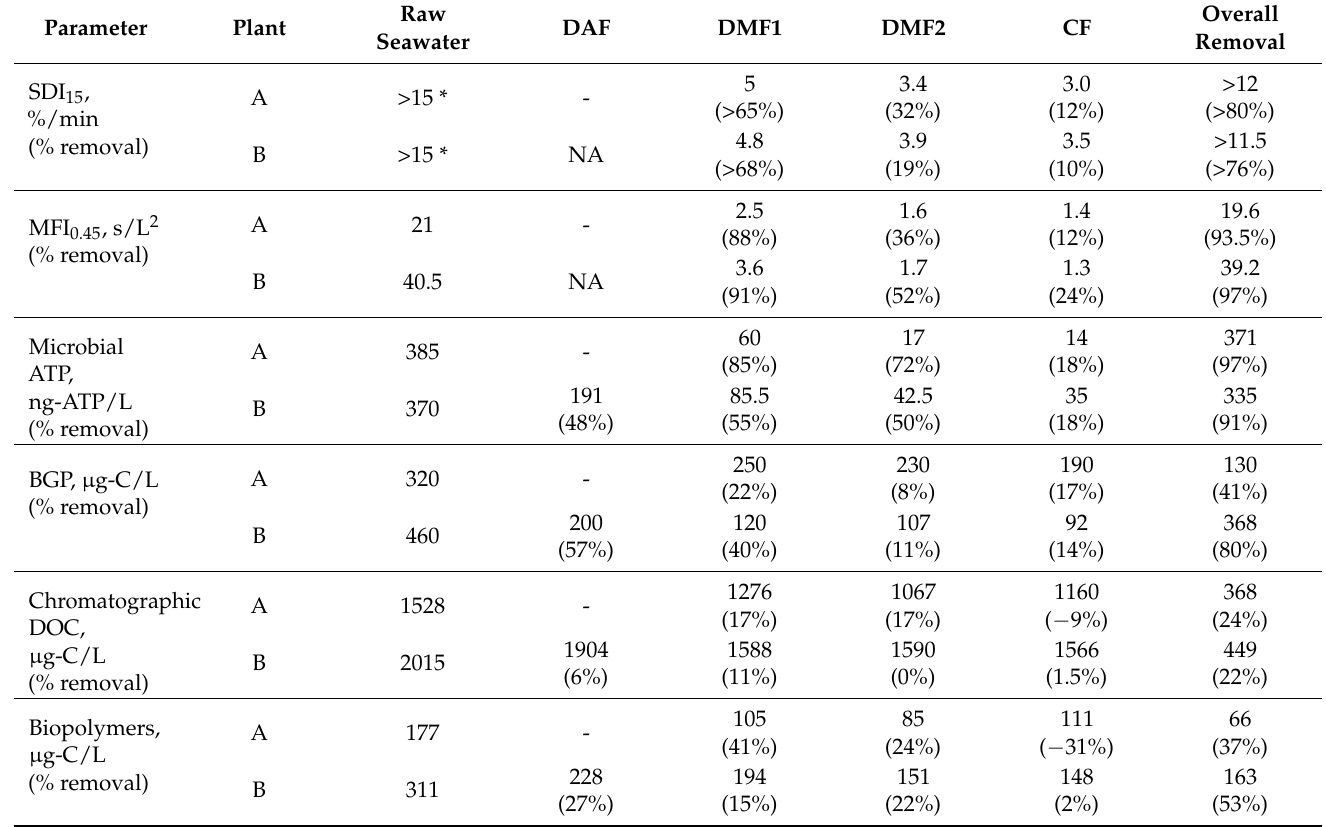
Table 5. Comparing dual media filtration (DMF) pretreatment (plant A) to dissolved air floatation followed with dual media filtration (DAF-DMF) pretreatment (plant